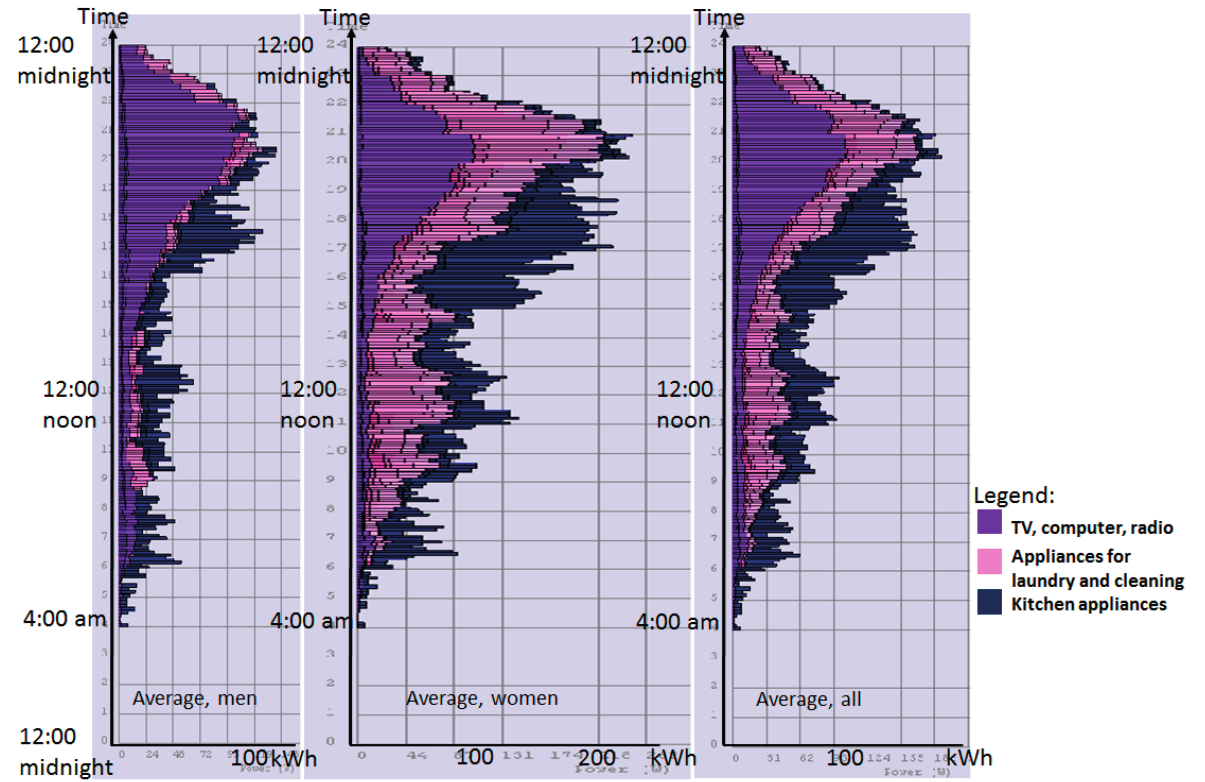
Figure 5. Average electricity demand derived from activities performed: men (left, maximum demand about 130 kWh per person and 5 min period), women (middle, maximum about 240 kWh per person and 5 min period) and average for all (right, maximum about 190 kWh per person) aged 15 years and over, weekdays in 1996. Power demand in kWh per person at 5-min